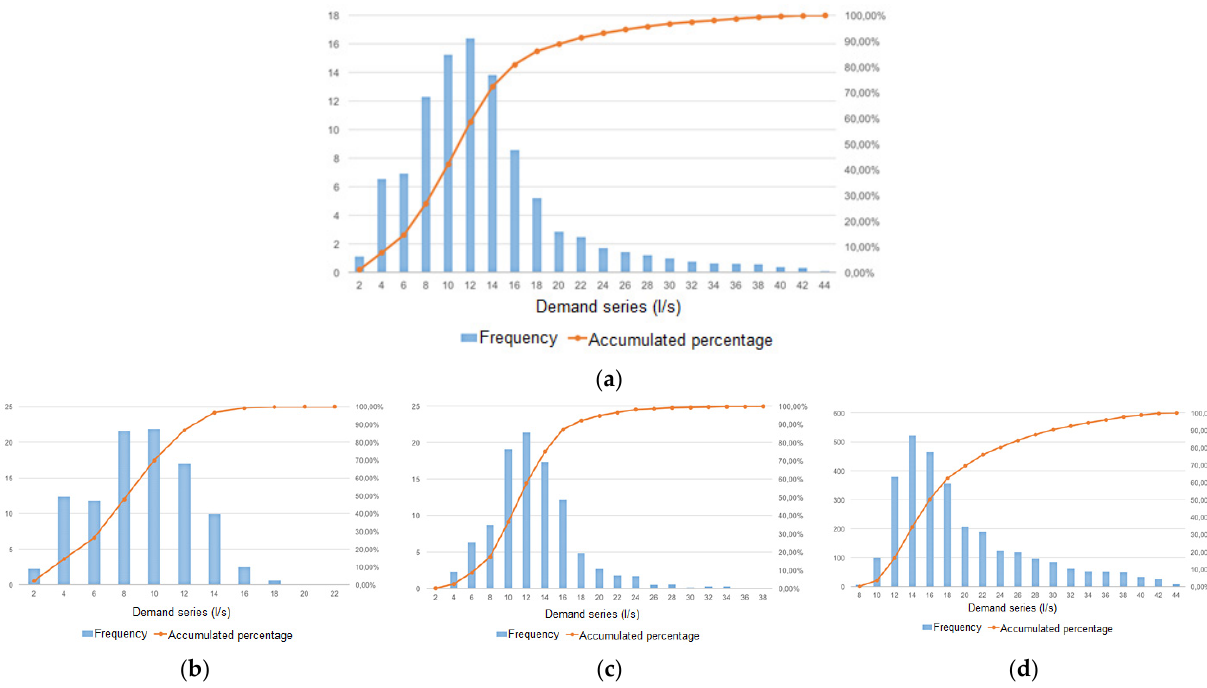
Figure 8. Demand distribution; ( a ) yearly; ( b ) normal; ( c ) high; ( d ) very high.